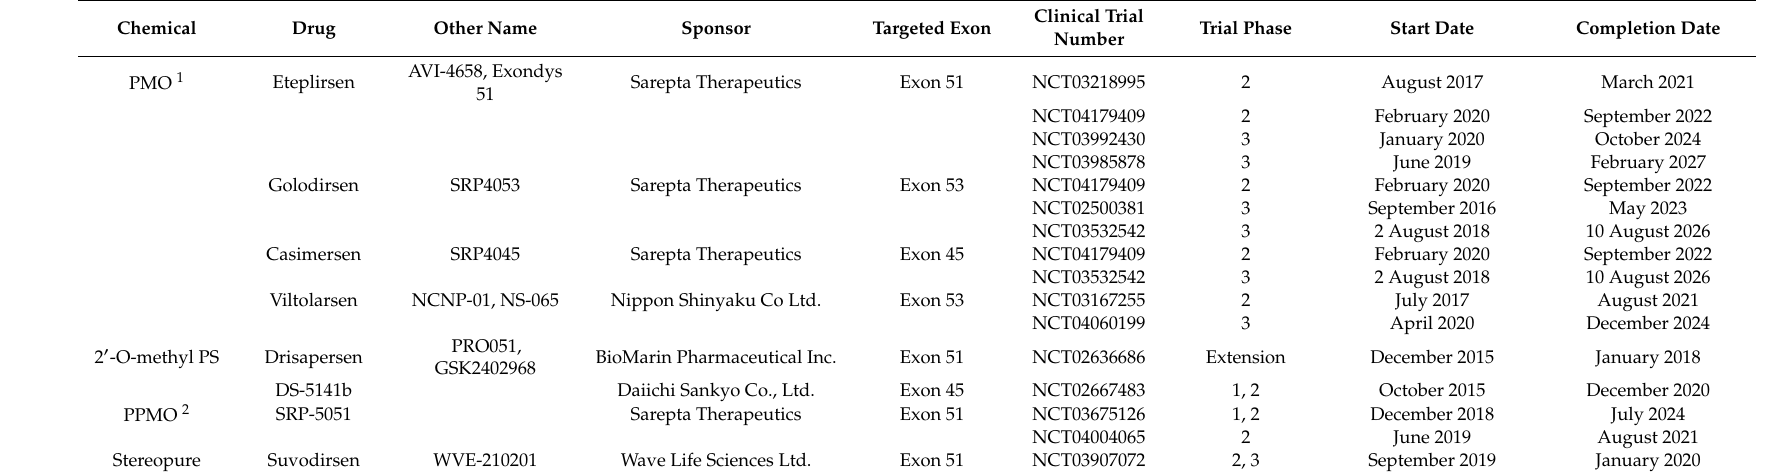
Table 1. Latest and ongoing clinical trials of exon skipping